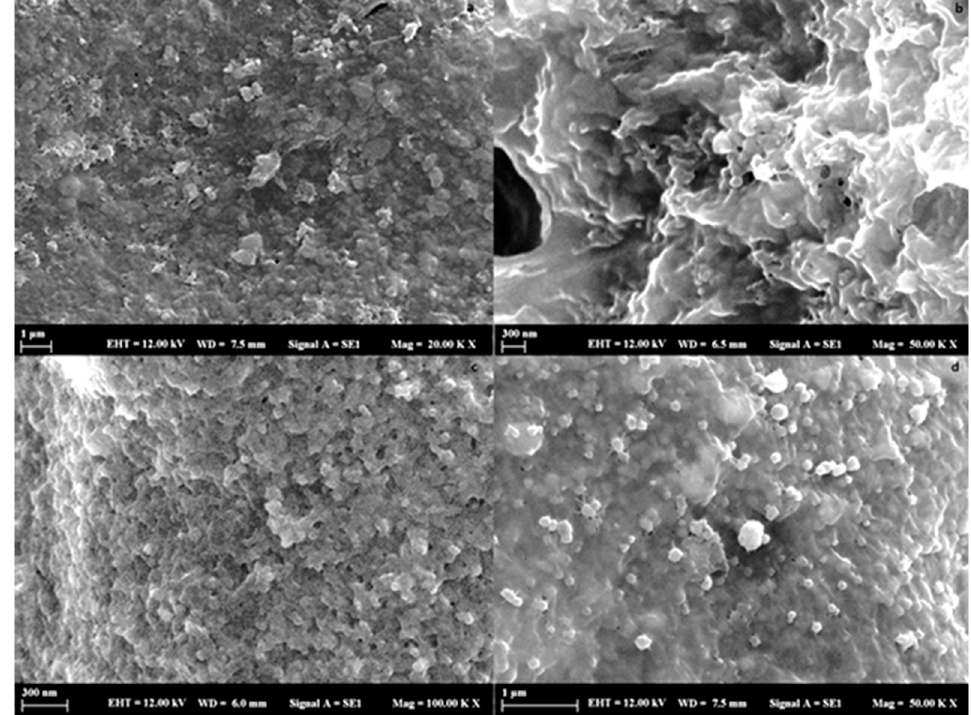
Figure 1. SEM images of the ( a ) RSGNP, ( b ) OPE-RSGNP, ( c ) CSGNP, and ( d ) OPE-CSGNP.